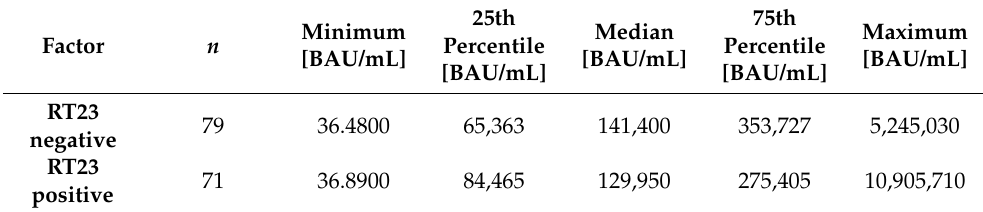
Table 17. The comparison of antibody levels between participants with positive and negative RT23 test